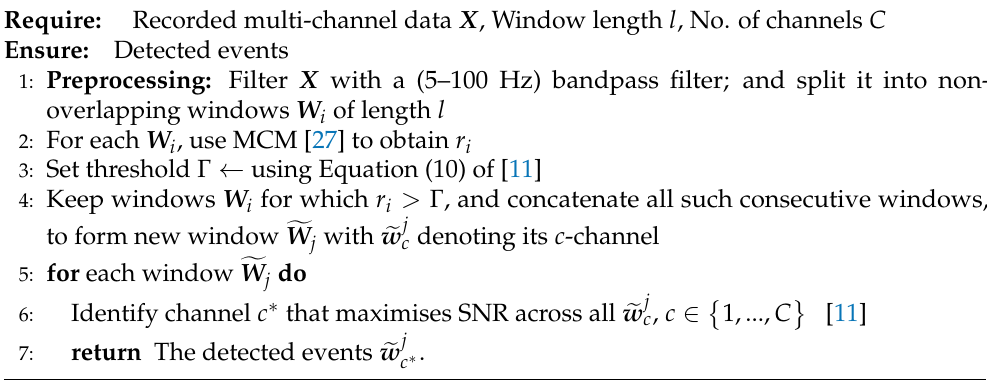
Algorithm 1 Multi-channel